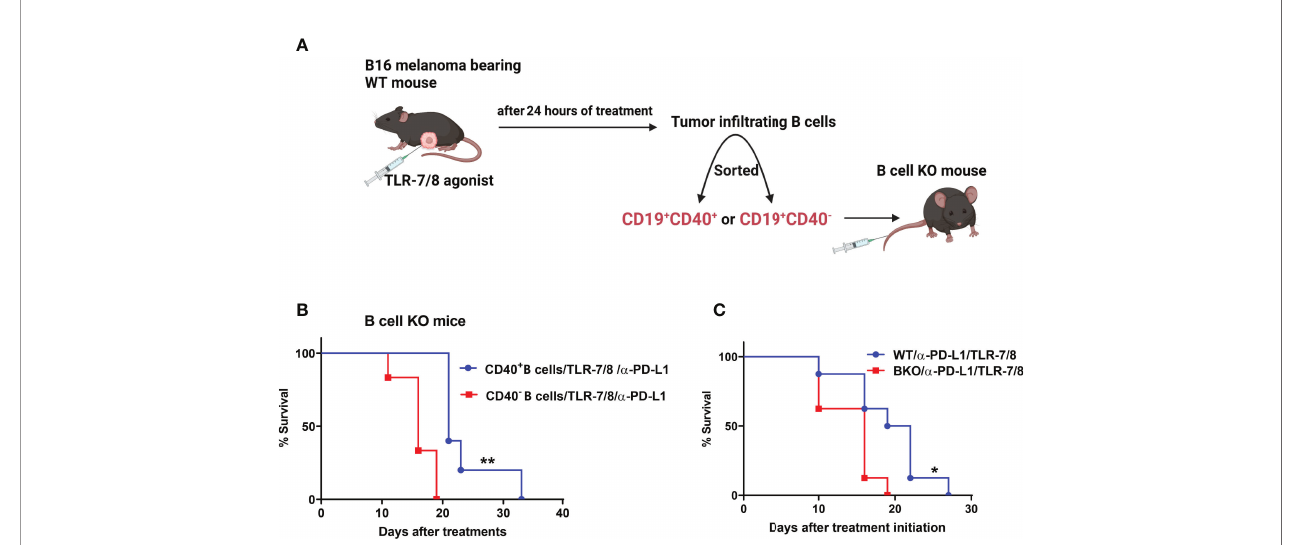
FIGURE 3 | CD40-positive B cells enhance the therapeutic ef fi cacy of anti-PD-L1 plus TLR-7/8 agonist therapy. (A) Experimental design. (B) B cell KO mice were treated with TLR-7/8 agonist plus anti-PD-L1 and received either 5000 CD19 + CD40 - B cells or 5000 CD19 + CD40 + B cells. (C) WT and B cell KO mice were treated with TLR-7/8 agonist plus anti-PD-L1. Kaplan-Meier survival curves, each with 5 to 6 mice per group. *P < 0.05, **P < 0.01, log-rank